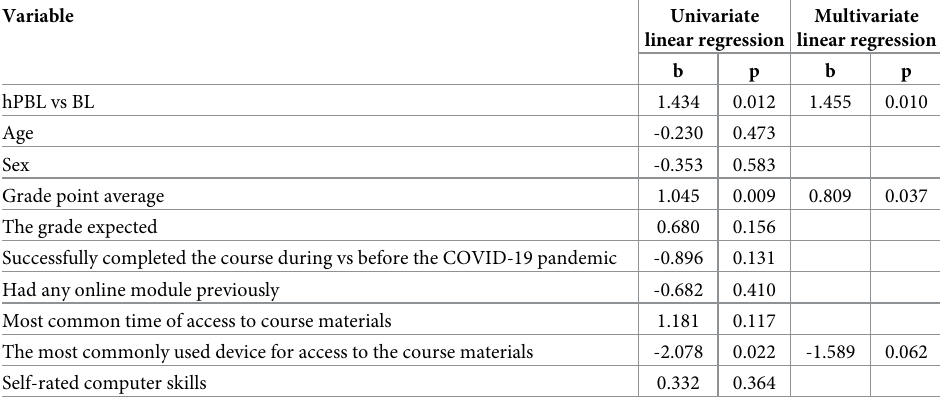
Table 4. Regression models with problem solving score as an outcome